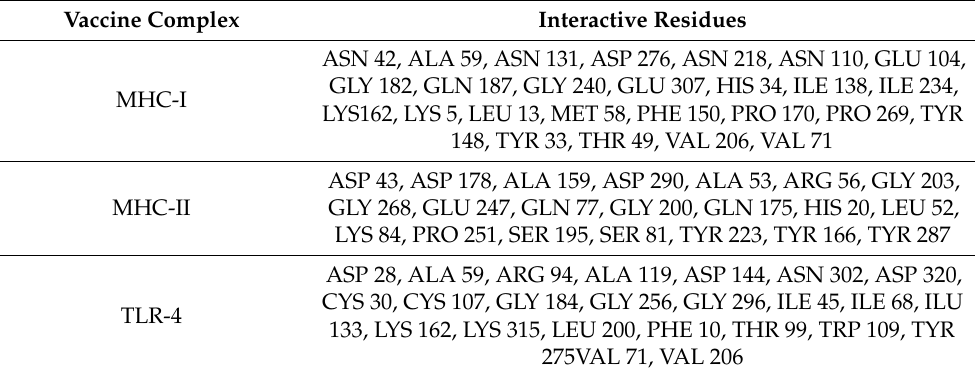
Table 13. Interaction between receptor residues and vaccine